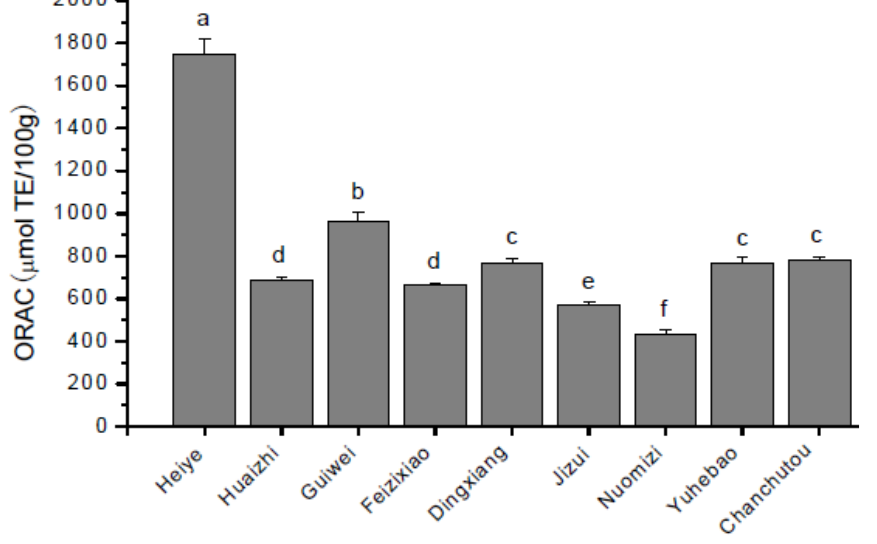
Figure 3. Oxygen radical absorbance capacity (ORAC) of phenolic extracts from the pericarp of nine litchi varieties (mean ± standard deviation, n = 6). Bars with no letters in common are significantly different ( p <